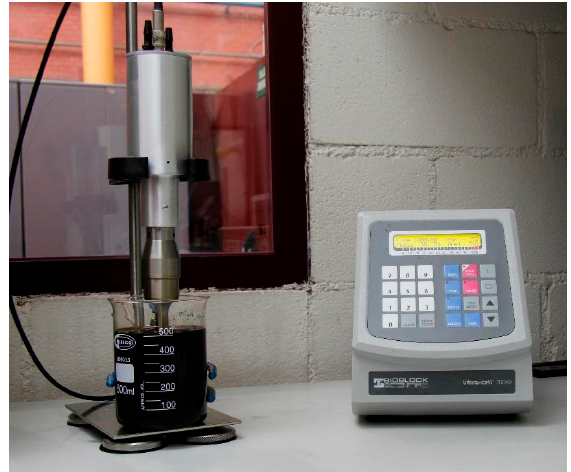
Figure 3. Sonicator 750 W used to produce the DNF.